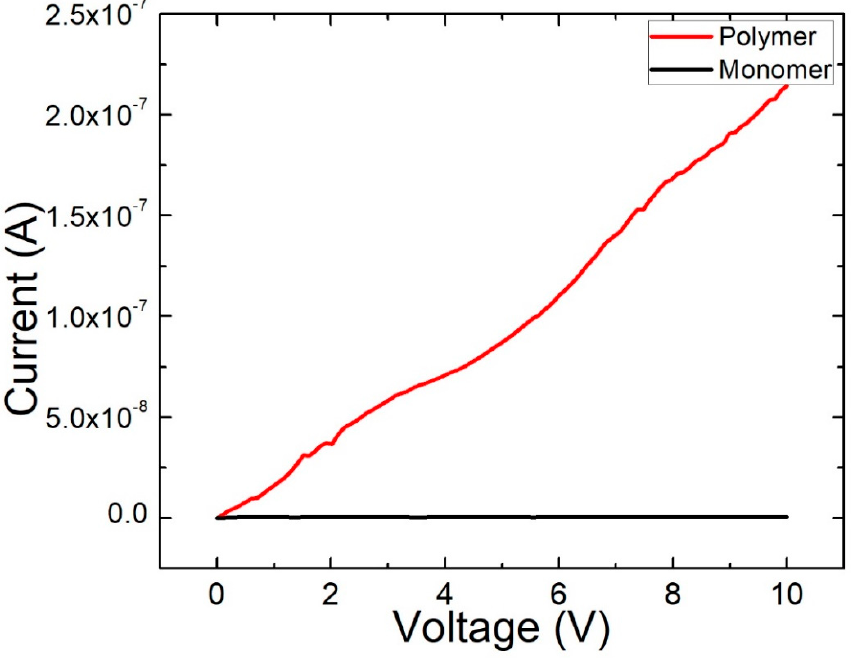
Figure 9. Conductivity of m -aminophenol film after plasma treatment.